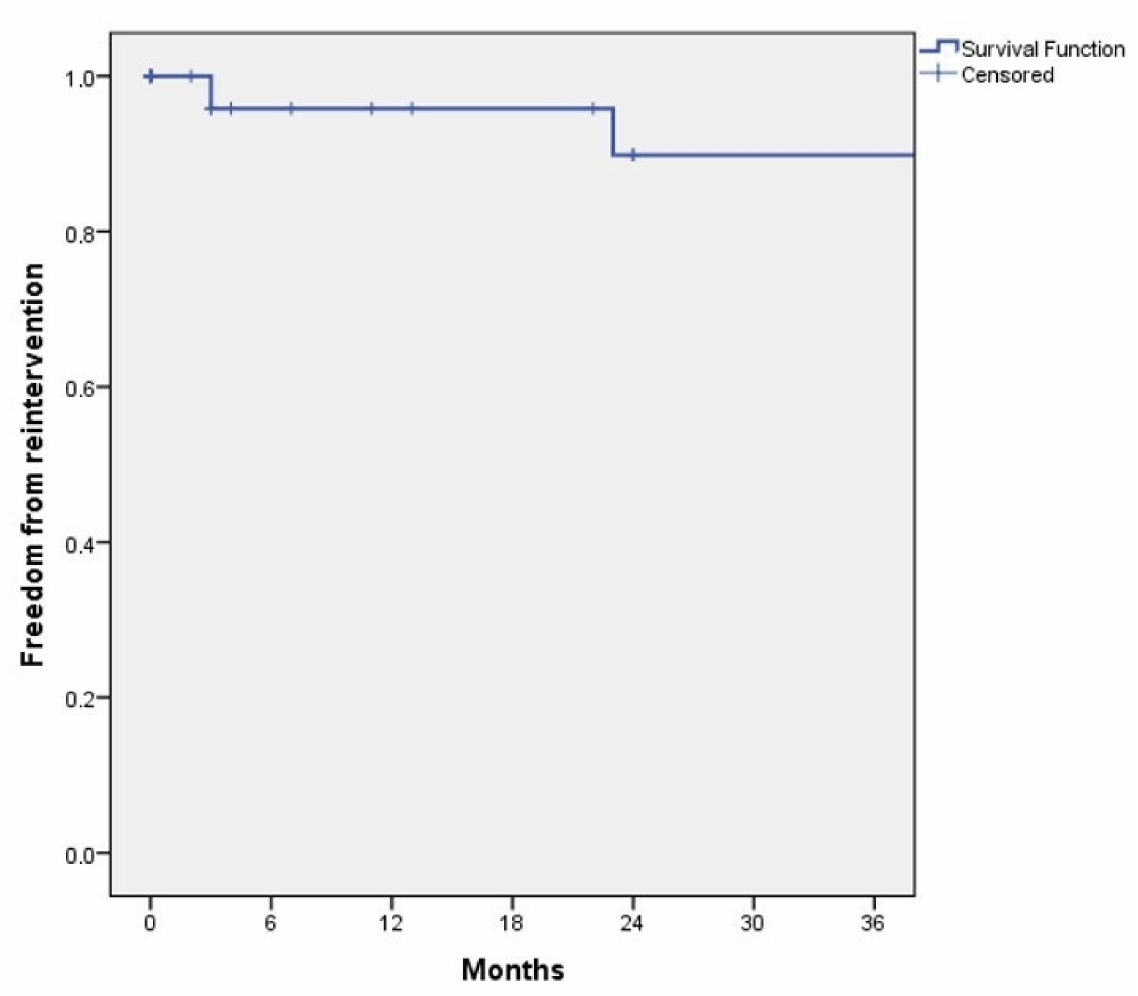
Figure 4. Kaplan–Meyer analysis of freedom from reintervention during